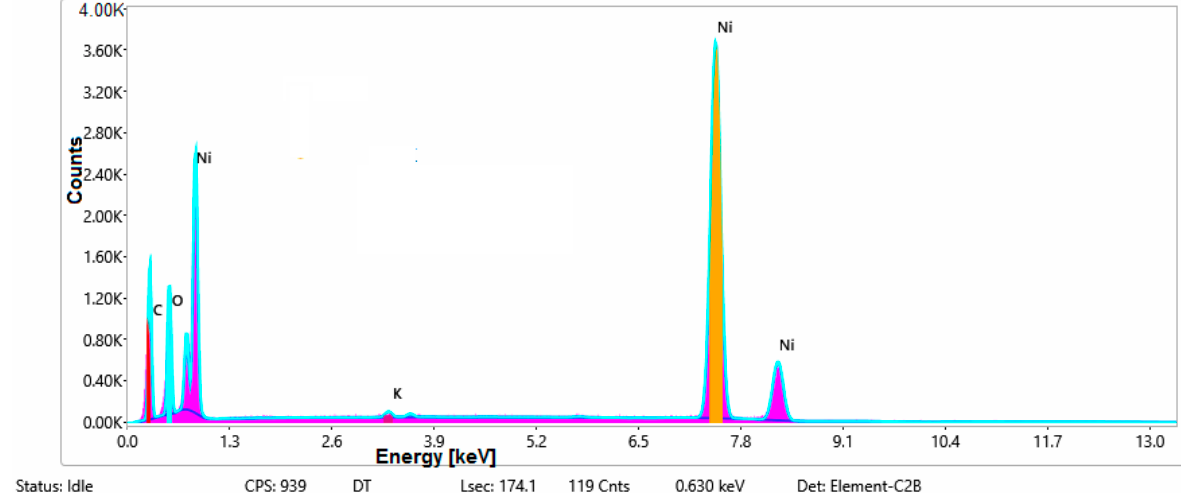
Figure 18. ESD spectra and elemental overlay for sample S3 treated in RF plasma O 2 , using RF 2 generator and power 100 W and Ni paste